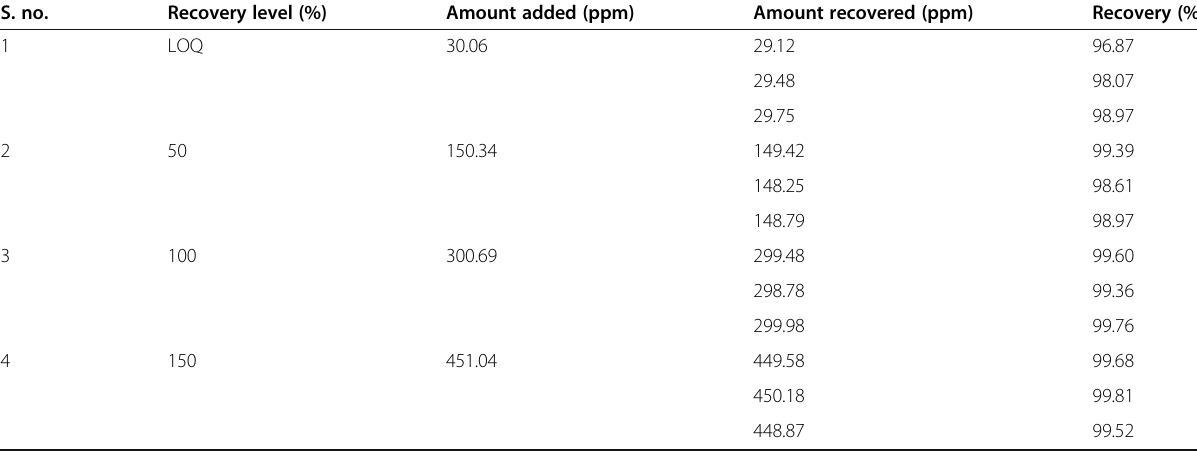
Table 13 Results of recovery study for n-hexane S.